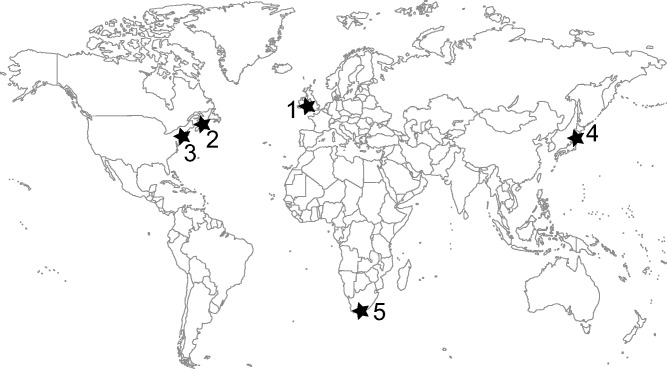
Geographical sampling of Spraguea isolates. Cysts were extracted from two to four fish at each of five locations worldwide. Site 1—Celtic Sea isolates (ex L. piscatorius): Celtic Deep (51.1921, Long. −5.6975), EM120 (West Lundy, 51.17535, −5.40448), RA12034 (Carmarthen Bay, 51.5459, −4.5872), North Atlantic (exact location unknown). Site 2—New Brunswick, Canada (ex Lophius americanus). Site 3 (ex Lophius americanus): JS61 (South of Pt. Judith, Rhode Island, USA, 40.9192, −71.7533), RM18 (Mud Hole, New Jersey, USA, 40.16666, −73.6666), RW92 (East of Ocean City, Maryland, USA, 37.9166, −74.7533). Site 4 (ex Lophiomus setigerus): Fukushima, Japan. Site 5 (ex Lophius vomerinus): Cape Town, South Africa. DNA was extracted from individual cysts, and each isolate was sequenced independently. A lack of evidence for heterozygosity on any of the genome assemblies suggests that each cyst arises from infection by a single haploid spore, or from a small clonal population.